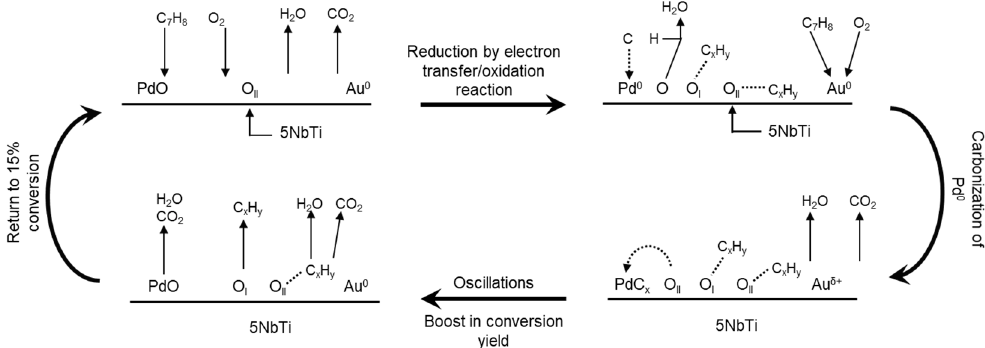
Figure 5. Proposed reaction scheme for the degradation of toluene over the PdAu5NbTi catalyst under ageing conditions.